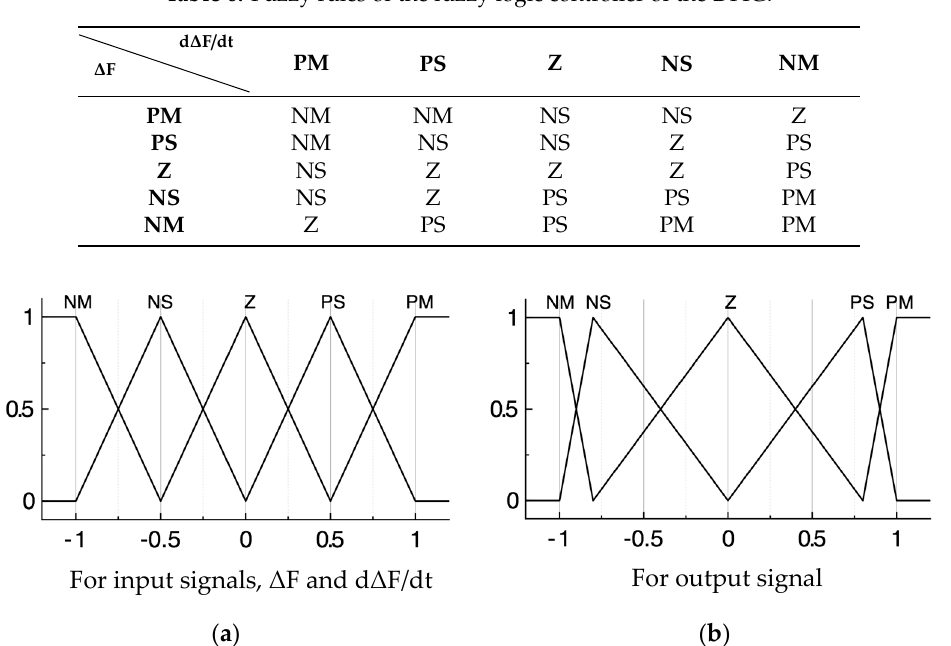
Figure 9. Reference correction of the DFIG active power depending on its rotor speed. 4. Cooperative Control of BESS It is well known that a battery system can contribute well to suppressing power system frequency fluctuations. In this study, it is assumed that a battery energy storage system (BESS) is installed near the consumer and can be regulated so as to suppress frequency fluctuations in cooperation with the ASG. Though a lot of schemes have been proposed for BESS power control, fuzzy logic control is adopted in this study, as shown in Figure 10. The design concept of the battery controller is the same as that of the ASG. According to frequency deviation, output power reference is calculated based on the fuzzy control parameters shown in Figure 11 and Table 7. However, the control gain for the input signal and the membership function of the fuzzy control system in the BESS are different from those of DFIG and are tuned to behave cooperatively to further enhance the effectiveness of the control by DFIG. The fuzzy control contains differential operations in order to respond quickly to fast changes in the frequency. This scheme of control is basically the same as the